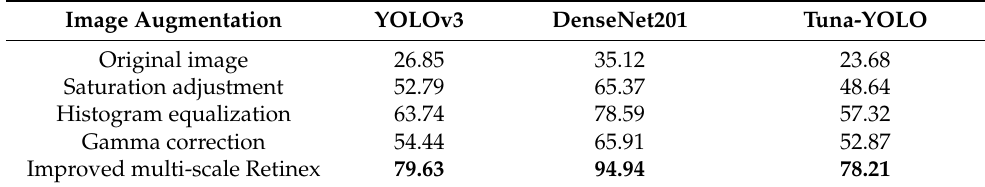
Table 4. mAP of network model in different augmentation algorithms.